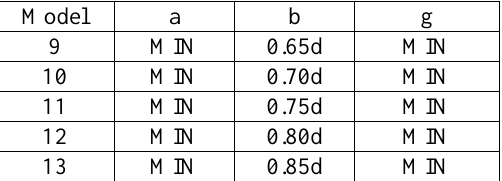
RBS flange cut dimensions with variable “b” values.